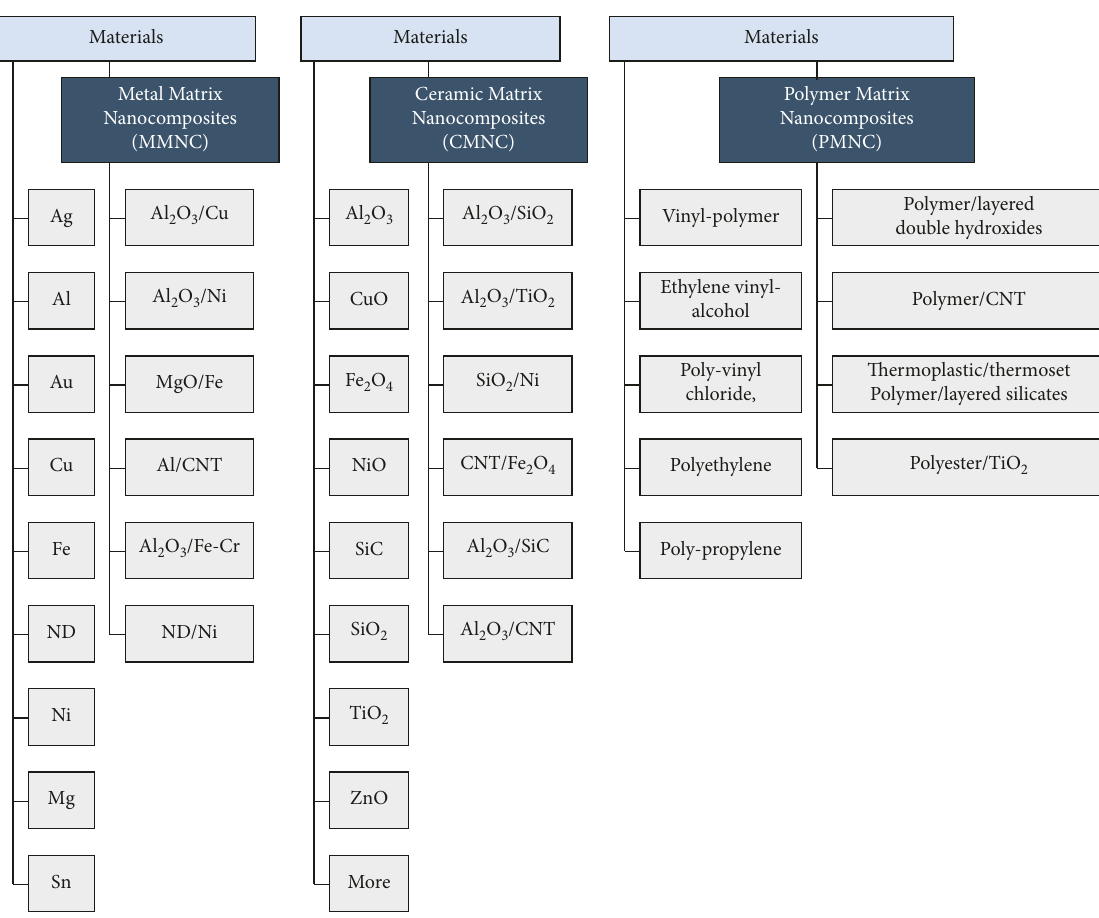
Figure 7: Classification of materials and nanocomposites.